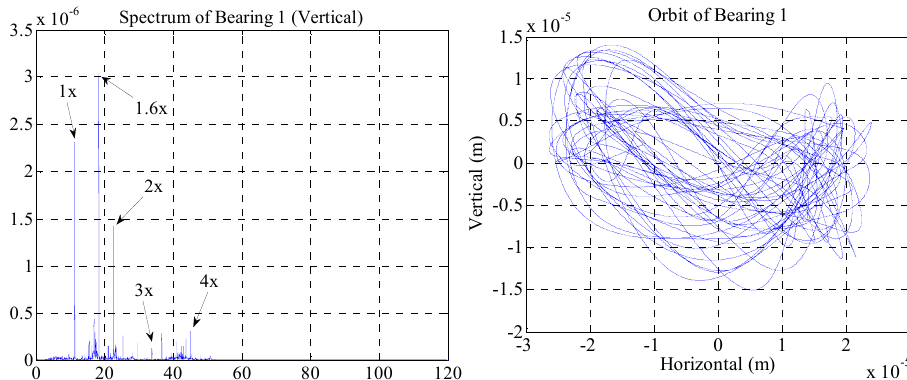
Figure 22. The spectrum and the orbit of Bearing 1.